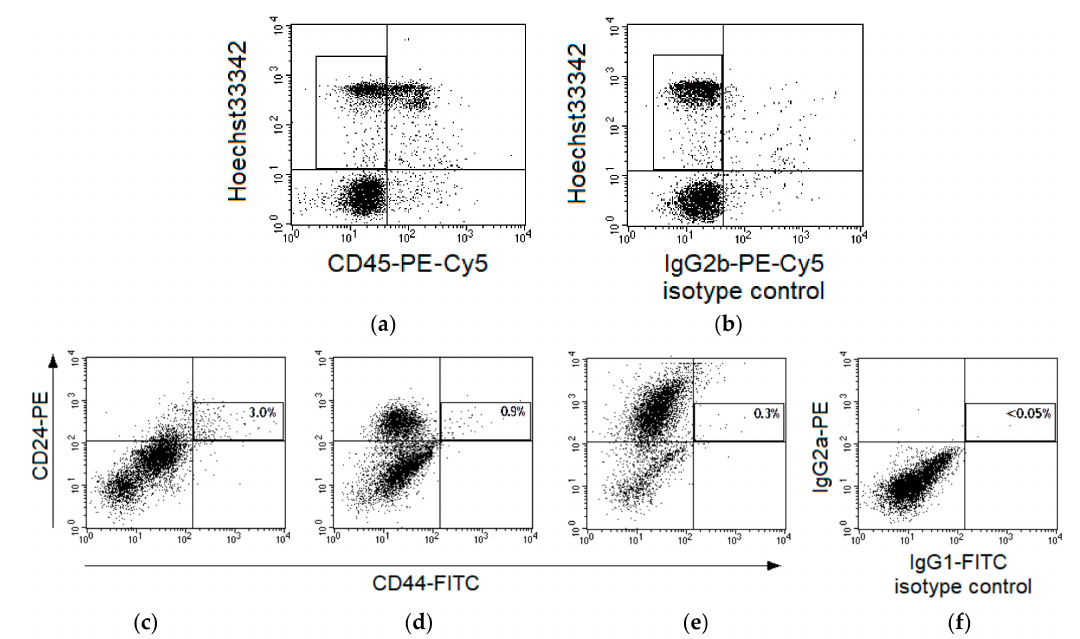
Figure 1. Gating strategy for identification of CD44 + CD24 low cells in cervical scrapings from patients with cervical cancer (CC). Typical fluorescence of cervical cells after staining with Hoechst33342 and monoclonal antibodies labeled with phycoerythrin (PE)-Cy5 to human CD45 ( a ) or limpet hemocyanin ( b ), isotype control of nonspecific binding). The region of CD45 - Hoechst33342 + events is selected for subsequent analysis. Representative dot plots for fluorescence of cervical cells in samples stained with antibodies to CD44-fluorescein isothiocyanate (FITC) and CD24-PE ( c – e ) or in a sample of isotype control ( f ). Cases with different expression of CD24 in the main part of cells are presented: no expression ( c ), relatively low expression ( d ), and relatively high expression ( e ). Each plot shows five thousand cells (part of the saved file for each case) after gating for CD45 - Hoechst33342 + events. The region of CD44 + CD24 low cells is highlighted and their percentage among CD45 - Hoechst33342 + events is indicated for the entire file.